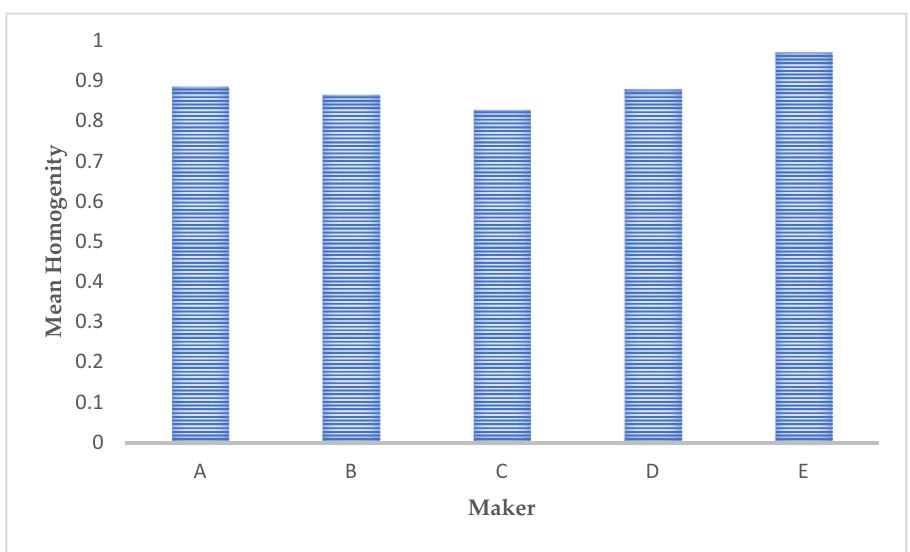
Figure 10. Comparison of the homogeneity values presented by the different microstructure images.